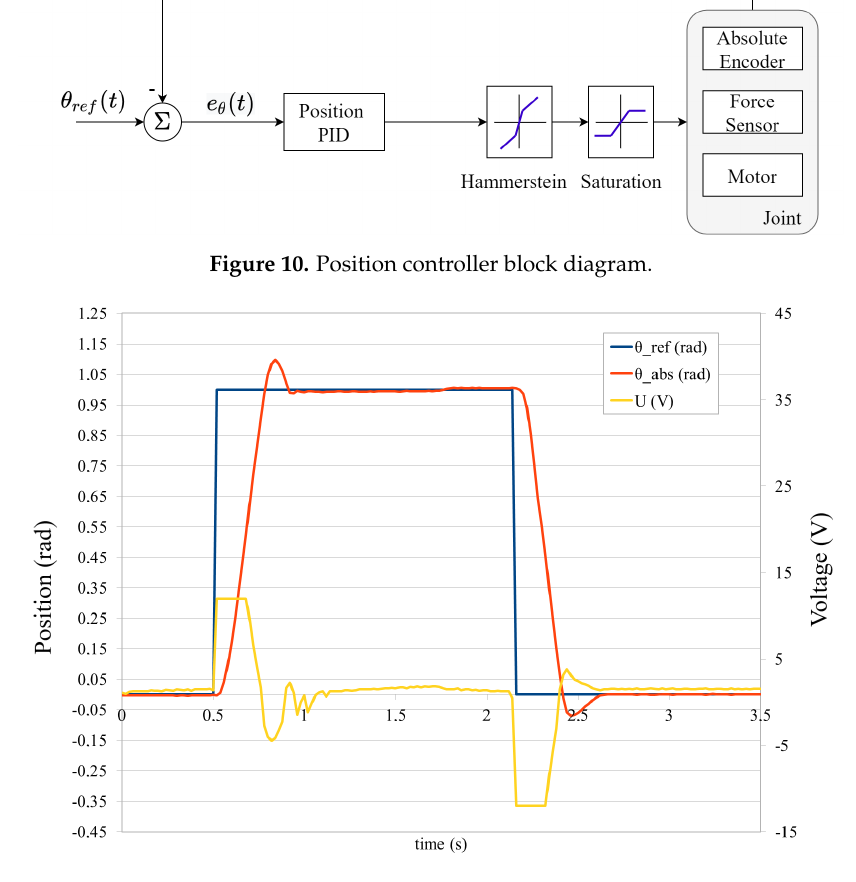
Figure 11. Response to a step in the position reference.